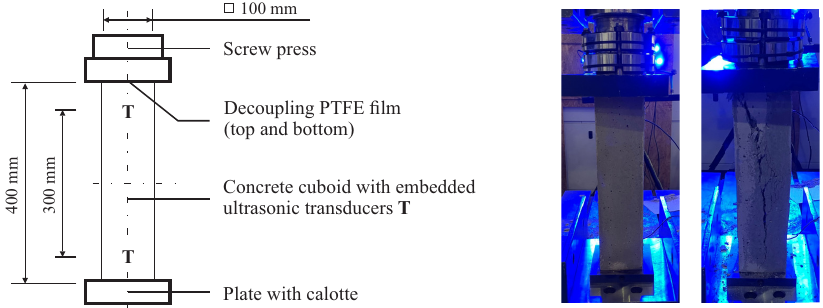
Figure 4. Setup for the uniaxial compression experiment: ( left ) sketch of the cuboid concrete speci- mens with their dimensions, ( center ) picture of the experiment, and ( right ) picture after failure. A pre-test with three identical specimens yielded a compressive strength of